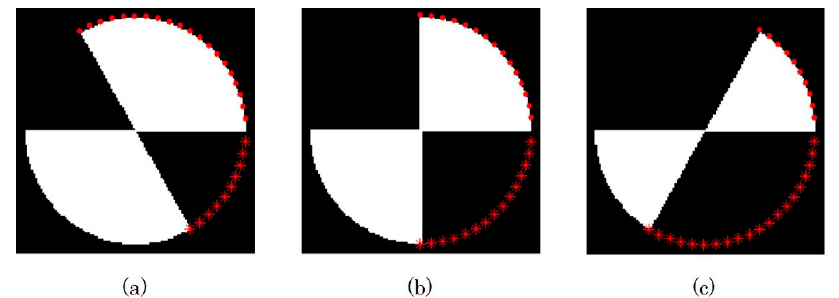
Figure 7. The position of the estimated detectors (dots “·”) and the corresponding image region to the missing detectors which needs compensation (white area in the image). The position of the measured detectors (dots “*”) and the corresponding known area of the image (black area in the image). Panels ( a – c ) refer to 60-views, 90-views and 120-views circular scanning, respectively.